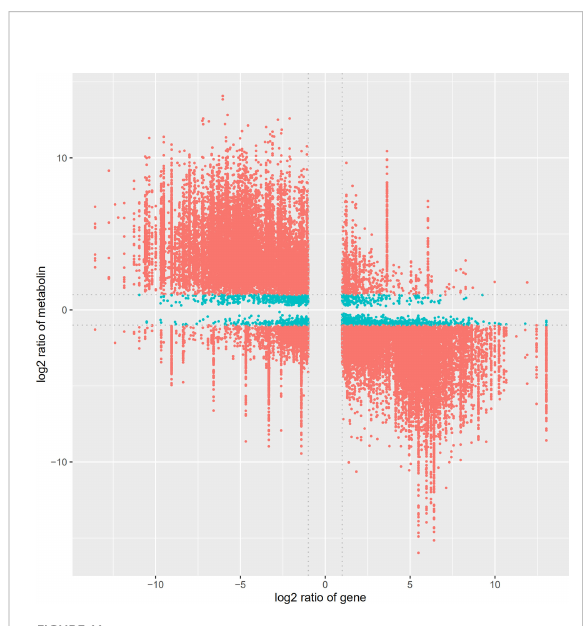
FIGURE 11 Nine quadrant diagram showing the correlation of differentially expressed genes and differential accumulated metabolites.